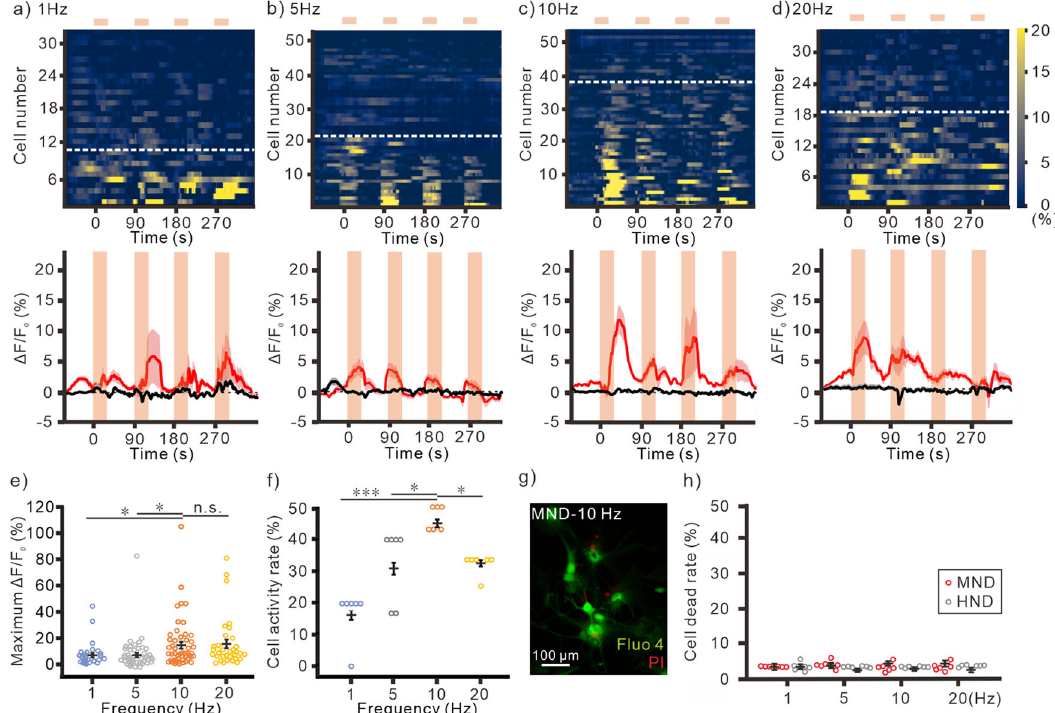
Fig. 3 Tuning the magnetic fi eld frequency for wireless stimulations. Multiple stimulations with 50 mT at 1 Hz ( a , n = 32/6 (neurons/samples)), 5 Hz ( b , n = 51/6), 10 Hz ( c , n = 52/6), or 20 Hz ( d , n = 34/6). top, Heatmap of Ca 2 + responses in individual neurons. The cells below white dash lines were activated during stimulations. bottom, The averaged traces of fl uorescence change. The light orange areas indicate the time periods of magnetic stimulation. Red line, MND group. Black line, HND group. Pink and gray area, s.e.m. e The maximum change of fl uorescence at different frequencies (1 Hz, n = 32/6 (neurons/samples); 5 Hz, n = 51/6; 10 Hz n = 52/6; 20 Hz, n = 34/6). F = 1.050, p < 0.001, Kruskal-Wallis test. f The cell activity rate of each culture sample at different frequencies (All groups, n = 6). F = 8.208, p < 0.001, Kruskal-Wallis test. * p < 0.05, *** p < 0.001, Dunn post-hoc test. g PI treatments in neurons with MNDs after magnetomechanical stimulation at 10 Hz. Green, Fluo-4; Red, PI. h Quantify of live-dead assay with stimulations at different frequencies (All groups, n = 6). F = 0.003, p = 0.995 for frequency; F = 0.003, p = 0.862 for type of nanodiscs; F = 0.022, p = 0.995 for interaction between frequencies and nanodiscs, Two-way ANOVA. Error bars represent mean ±